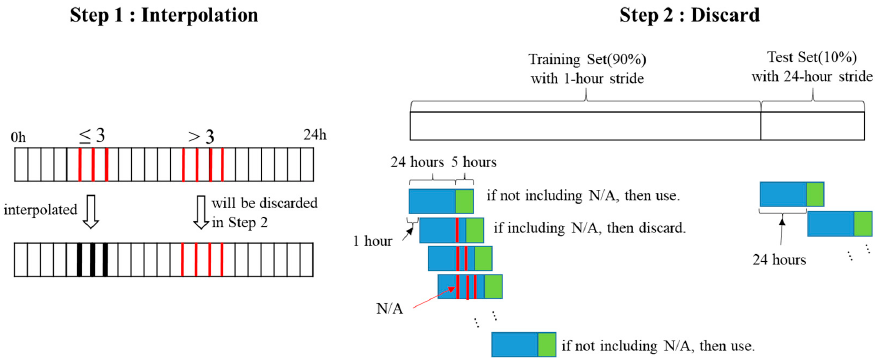
Figure 4. Two-step preprocessing of satellite images.